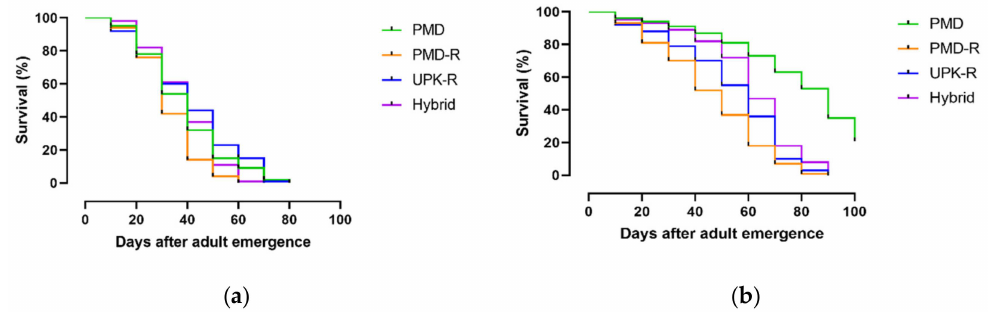
Figure 3. Survival curves of males ( a ) and females ( b ) of PMD, PMD-R, and UPK-R strains, and F 1 (PMD-R × UPK-R) hybrid under laboratory conditions.